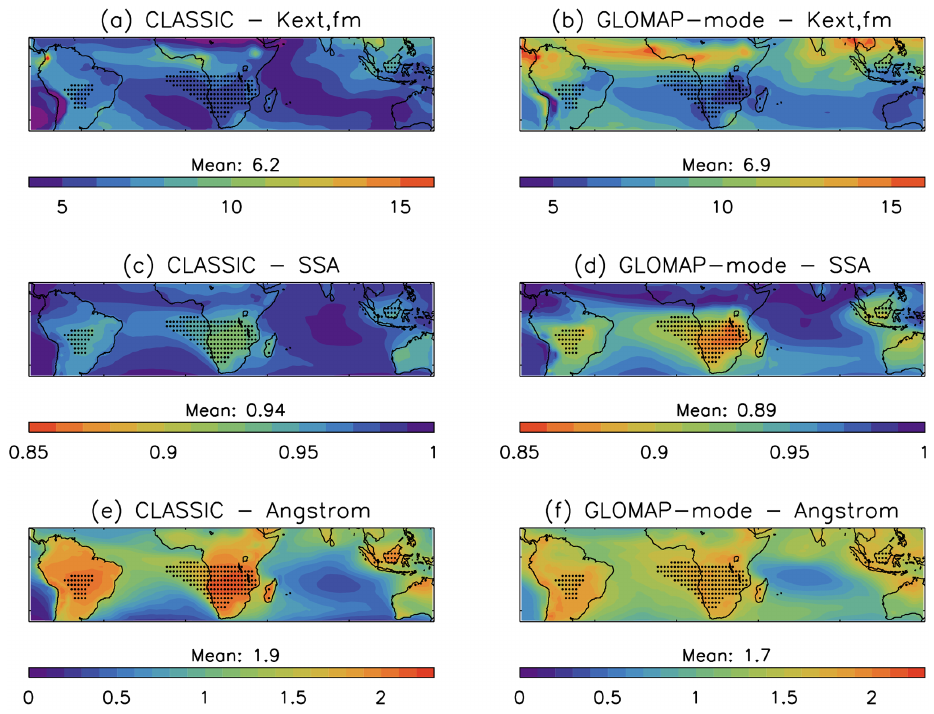
Figure 11. Column average moist aerosol optical properties from CLASSIC and GLOMAP-mode for the September long-term monthly mean. Properties are the fine-mode specific extinction coefficient ( k ext,fm ) , single scattering albedo (SSA) and the Ångström exponent. Stipples indicate grid columns where more than 75% of the fine-mode aerosol mass originates from biomass burning emissions (based on the speciation in the CLASSIC simulation). Mean values beneath each plot give the average from grid columns marked by these stipples.